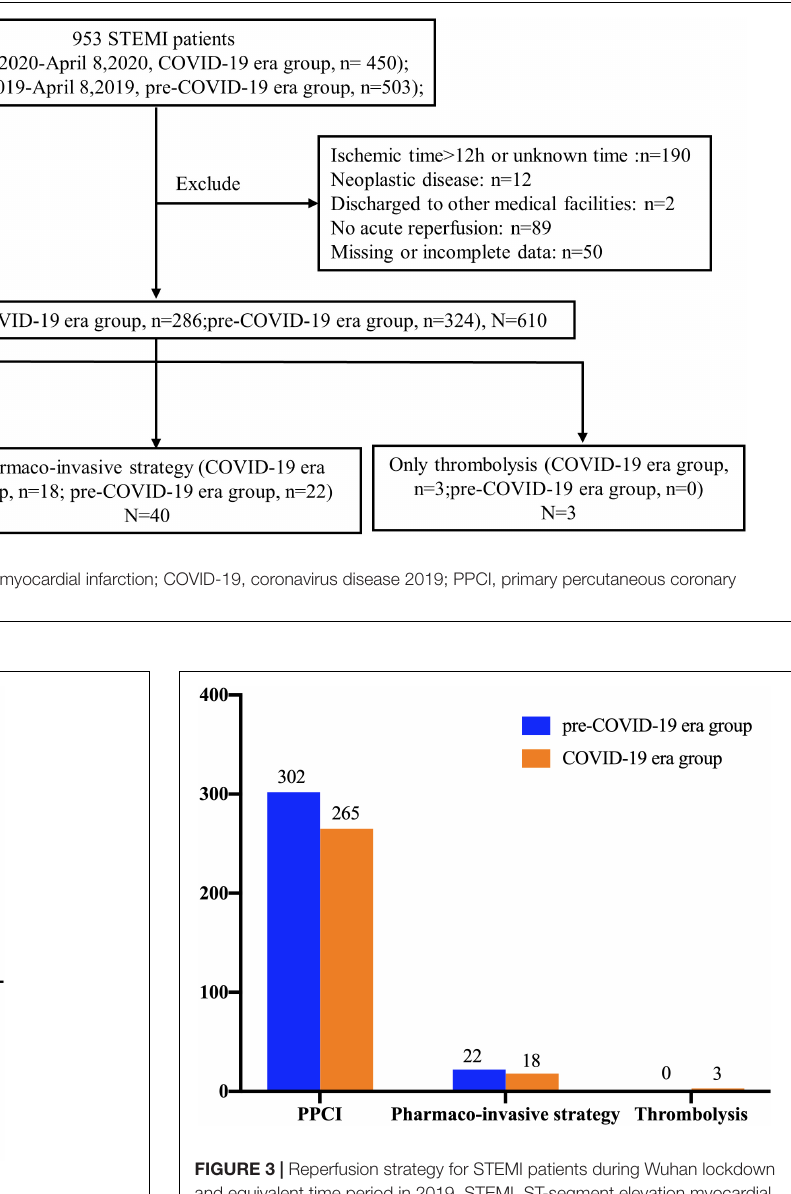
FIGURE 2 | Admissions for STEMI during Wuhan lockdown and equivalent time period in 2019. STEMI, ST-segment elevation myocardial infarction; COVID-19, coronavirus disease 2019.